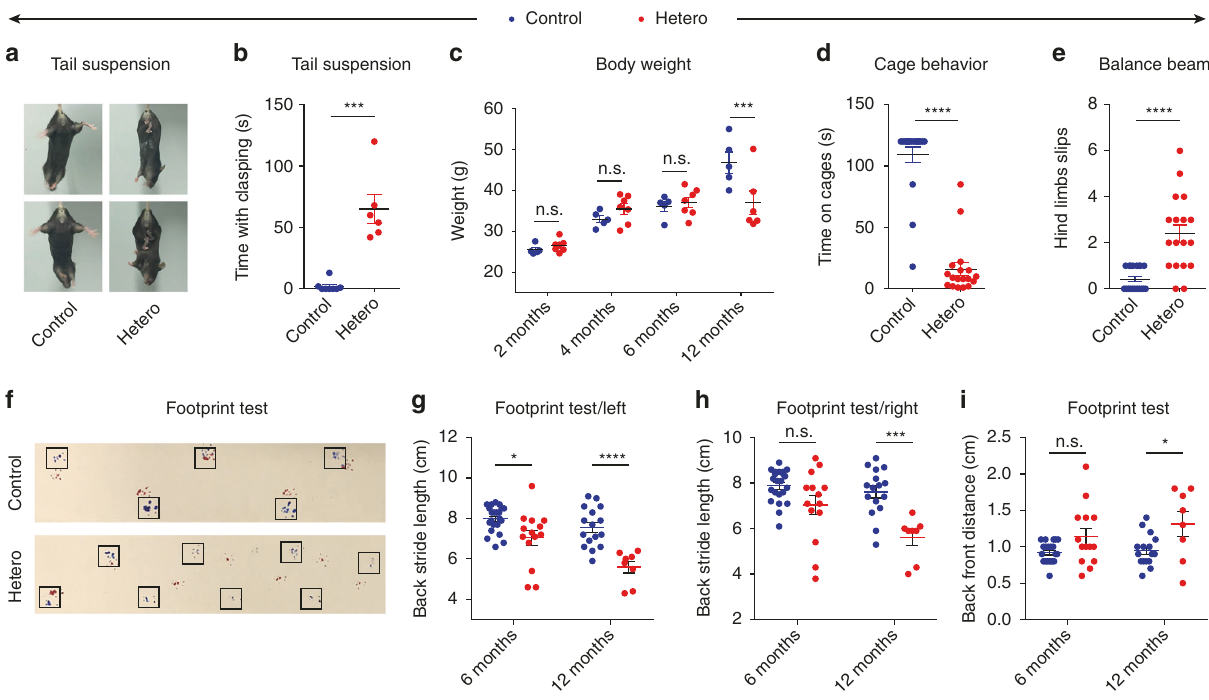
Fig. 3 GFP-PR 28 heterozygous mice show motor de fi cits. a Representative images of male control and GFP-PR 28 heterozygous mice at 2 months of age in tail-suspension test. b Quanti fi cation of the clasping time of mice in ( a ) during 2 -min test. Mann – Whitney test, n = 8, 6 mice. c Body weight of male control and GFP-PR 28 heterozygous mice at 2, 4, 6, and 12 months old. Two-way ANOVA, Bonferroni post hoc test; n = 5, 7 mice. d Quanti fi cation of time keeping on the edges of cages of male control and GFP-PR 28 heterozygous mice at 6 months of age. Mann – Whitney test, n = 19, 18 mice. e The numbers of hind limb foot slips on the balance beam test of male control and GFP-PR 28 heterozygous mice at 6 months of age. Mann – Whitney test, n = 19, 18 mice. f Representative images of male control and GFP-PR 28 heterozygous mice at 12 months of age in footprint test. Fore paws (red), hind paws (blue). Black squares indicate localization of hind paws. g Back stride length (left) of 6-, 12-month-old male control and GFP-PR 28 heterozygous mice measured in footprint test. Two-way ANOVA, Bonferroni post hoc test; 6 months, n = 22, 14 mice; 12 months, n = 16, 8 mice. h Back stride length (right) of 6-, 12- month-old male control and GFP-PR 28 heterozygous mice measured in footprint test. Two-way ANOVA, Bonferroni post hoc test; 6 months, n = 22, 14 mice; 12 months, n = 16, 8 mice. i Back-front distance measured in footprint test of male control and GFP-PR 28 heterozygous mice at 6, 12 months of age. Two-way ANOVA, Bonferroni post hoc test; 6 months, n = 22, 14 mice; 12 months, n = 16, 8 mice. All data are displayed as mean ± s.e.m. * P < 0.05, *** P < 0.001, **** P < 0.0001, n.s. not signi fi motor neurons are involved in the phenotypes, so we performed Thy1-Cre + (heterozygote) mice were utilized for exploring the hind and fore limbs grip strength test. Surprisingly, GFP-PR 28 het- pathological and behavioral features. To determine whether the heterozygous mice expressing GFP-PR 28 show motor defects, we erozygous mice performed as well as control mice at 6 months of fi rst performed tail-suspension test. Hind limbs clasping and sus- age (Supplementary Fig. 2b, c). Meanwhile, there was no signi fi cant tained trembling were found in GFP-PR 28 heterozygous mice at difference in the body weight between control and GFP-PR 28 het- 2 months of age, but not in control mice (Fig. 3a). We supposed that erozygous male mice at 2, 4, and 6 months of age (Fig. 3c). However,